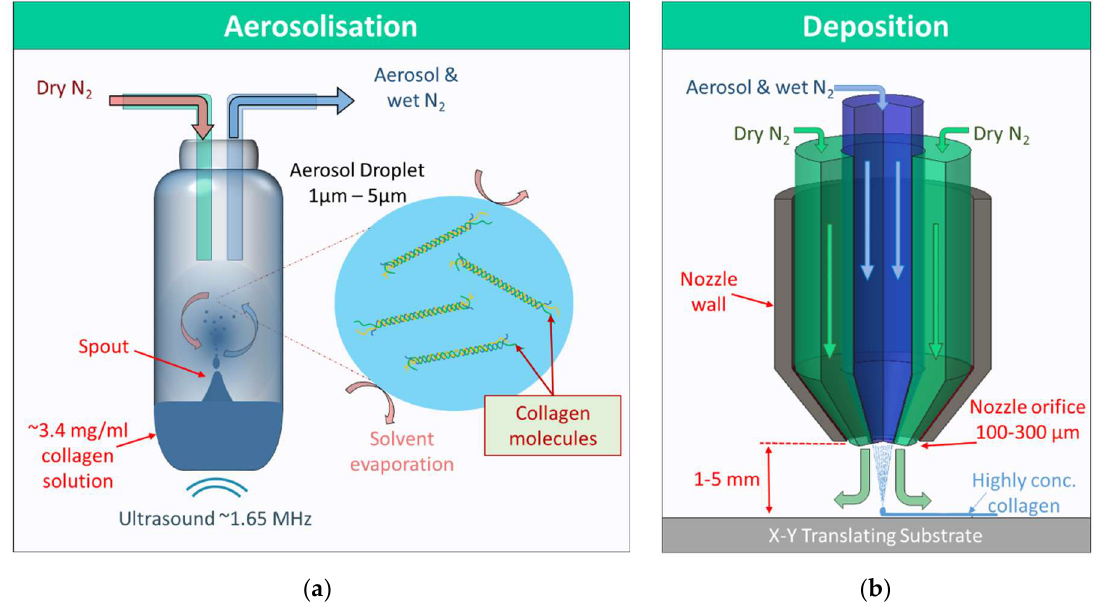
Figure 1. ( a ) Aerosolisation begins with 1.65 MHz ultrasonic waves forming a spout in the vial containing the collagen solution. Aerosol droplets are dispersed from the spout and become entrained in a nitrogen gas flow towards the deposition head. The rate of solvent evaporation is high due to the high surface area to volume ratio of the aerosol droplets and the dry nitrogen gas. ( b ) The aerosol and high humidity N 2 is collimated by a co-axial flow of nitrogen, which further dries the aerosol droplets and separates them from the walls of the nozzle. The aerosol coalesces on a XY translating substrate forming highly concentrated collagen printed lines.